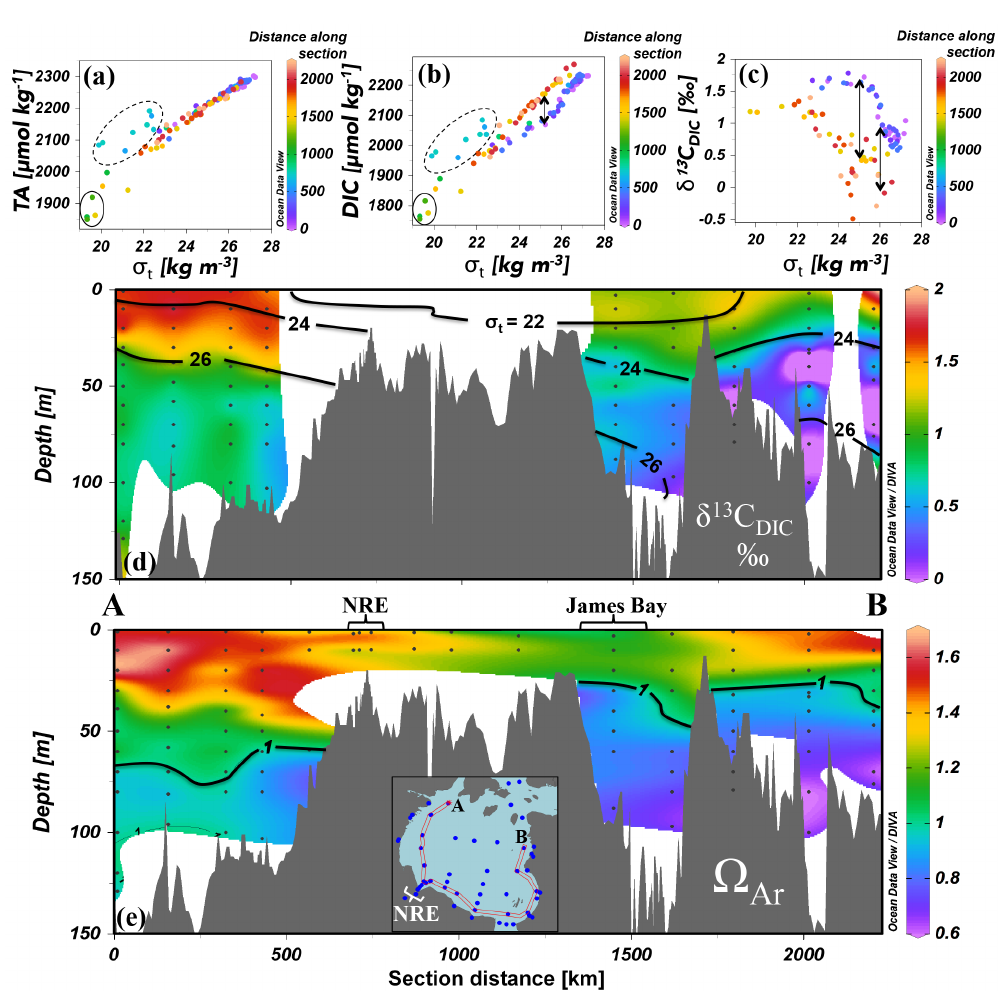
Figure 6. Variations in TA (a) , DIC (b) , and δ 13 C DIC (c) with in situ density anomaly ( σ t , observed density – 1000kgm − 3 ) along the northwest–northeast (A–B) coastal transect (inset map of transect is shown in lower panel). Dashed ellipses surround data within the NRE, while solid ellipses surround data with f _SIM ≥ 0.05 (located along southern coastline). Vertical arrows illustrate differences in DIC and δ 13 C DIC between waters in western Hudson Bay (blue–purple points) and eastern Hudson Bay (red–yellow points). Note that δ 13 C DIC was not sampled during the latter part of the cruise (i.e., along the southern coast). (d) Cross section of δ 13 C DIC along the coastal transect with isopycnals of in situ density anomaly ( σ t , kgm − 3 ) . (e) Cross section of (cid:127) Ar with solid line representing the aragonite saturation horizon ( (cid:127) Ar =